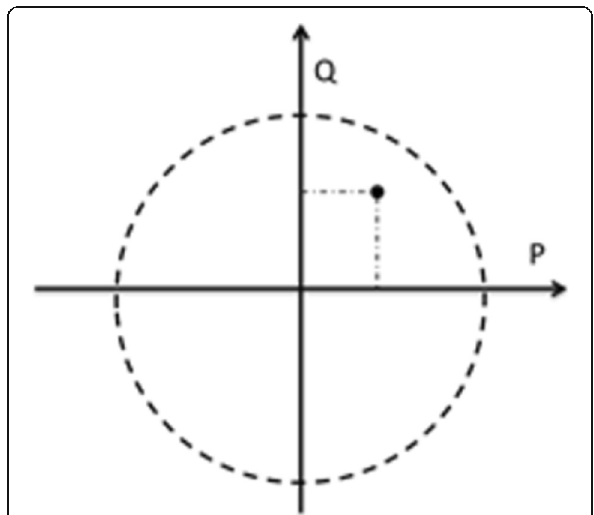
Fig. 7 Active and Reactive Power of Battery